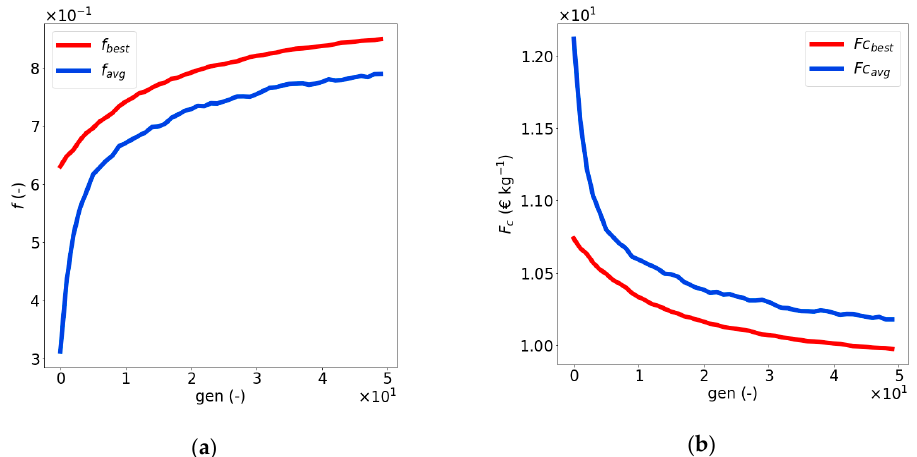
Figure 10. Averaged over 100 evolutions ( a ) fitness and ( b ) cost function evolution according to the generation.